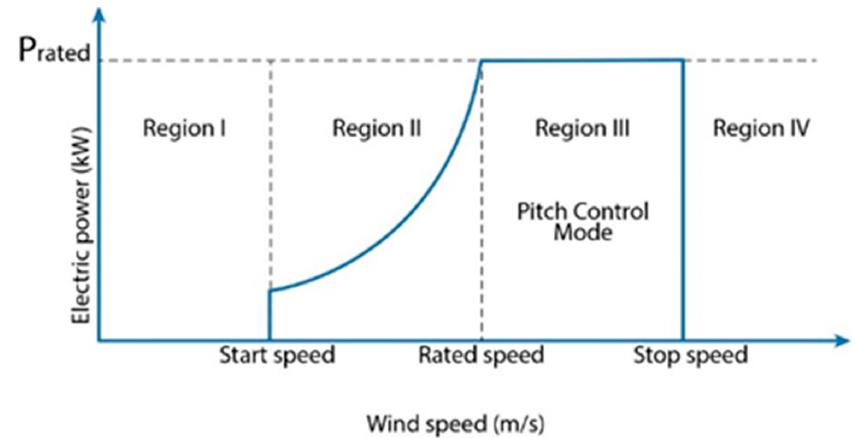
Figure 1. The influence of the pitch angle in C p . If the value of β increases, C p decreases.